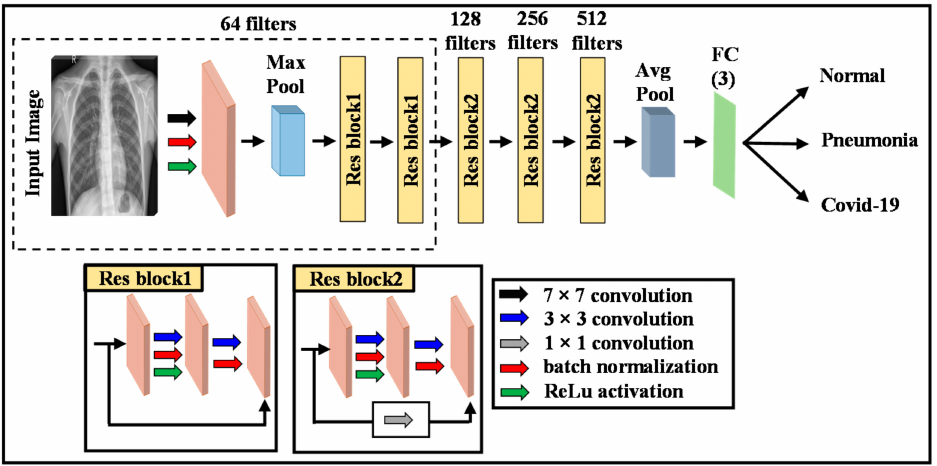
Figure 2. ResNet-18 architecture used in the proposed method. Res block1 is a regular ResNet block and Res block2 is a ResNet block with 1 × 1 convolution. FC stands for fully connected layer with 3